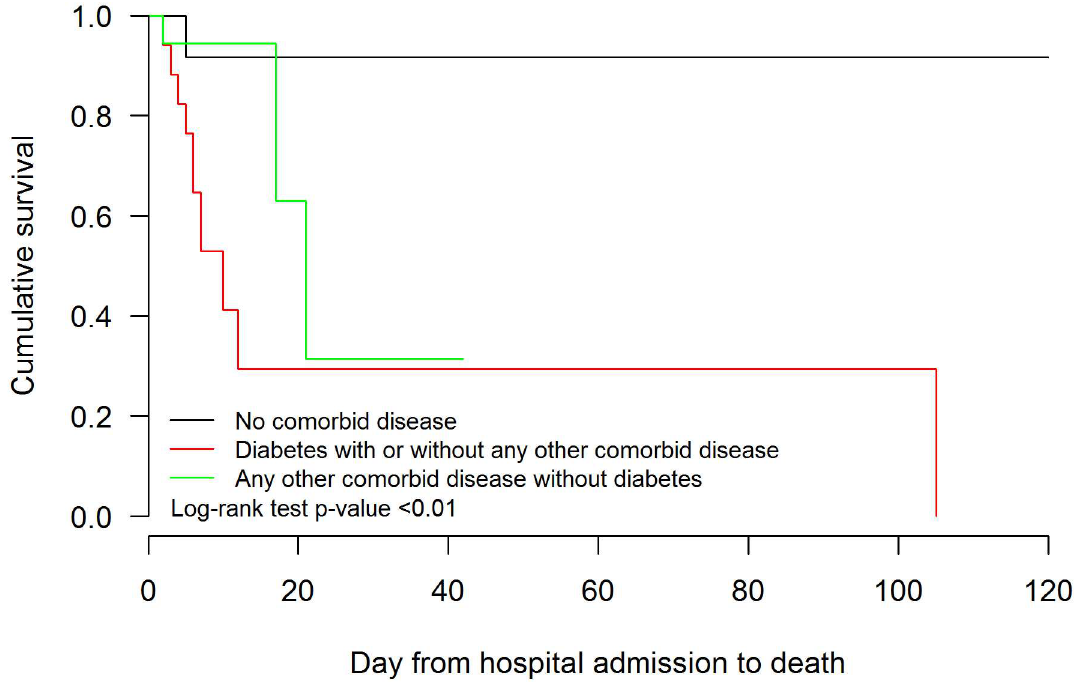
Fig 2. Time from hospital admission to death stratified by comorbid disease status among MERS positive cases. Survival analysis was carried out to ascertain impact of co-morbidities on survival in patients with MERS-CoV infection. Black line (group 1): No comorbid disease; Red line (group 2): Diabeteswith or without other comorbidities; Green line (group 3): Any other comorbid disease without diabetes. Log rank test: group 1 vs group 2 p = 0.01; Group 1 vs. group 3 p = 0.54; group 2 vs. group 3 p =